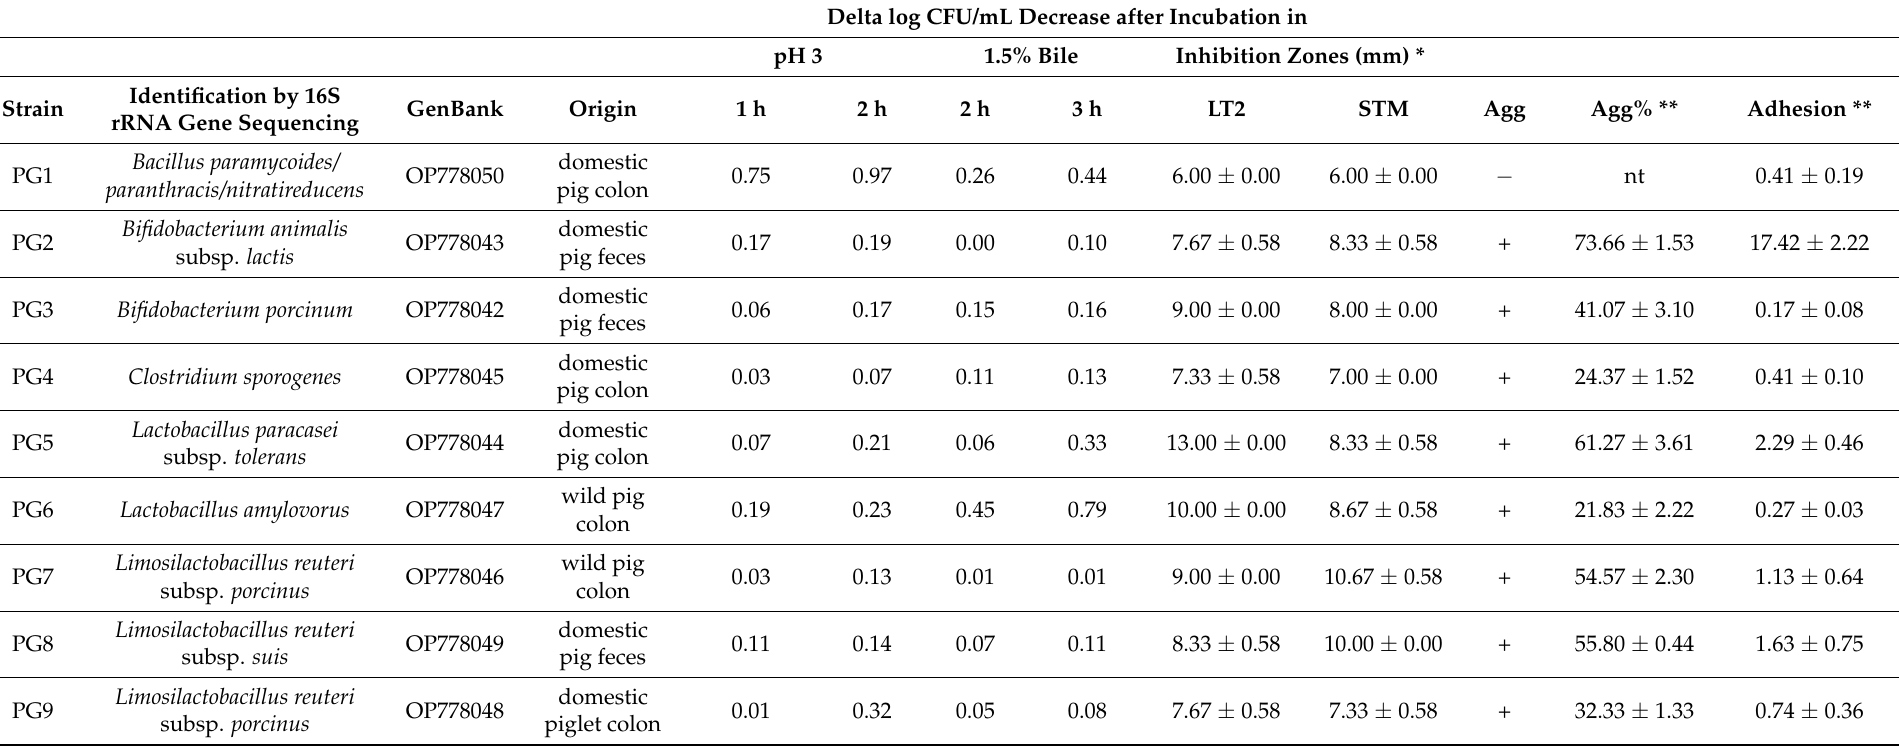
Table 3. Identification and functional properties of commensal bacteria isolated from pig and piglet colon and fecal